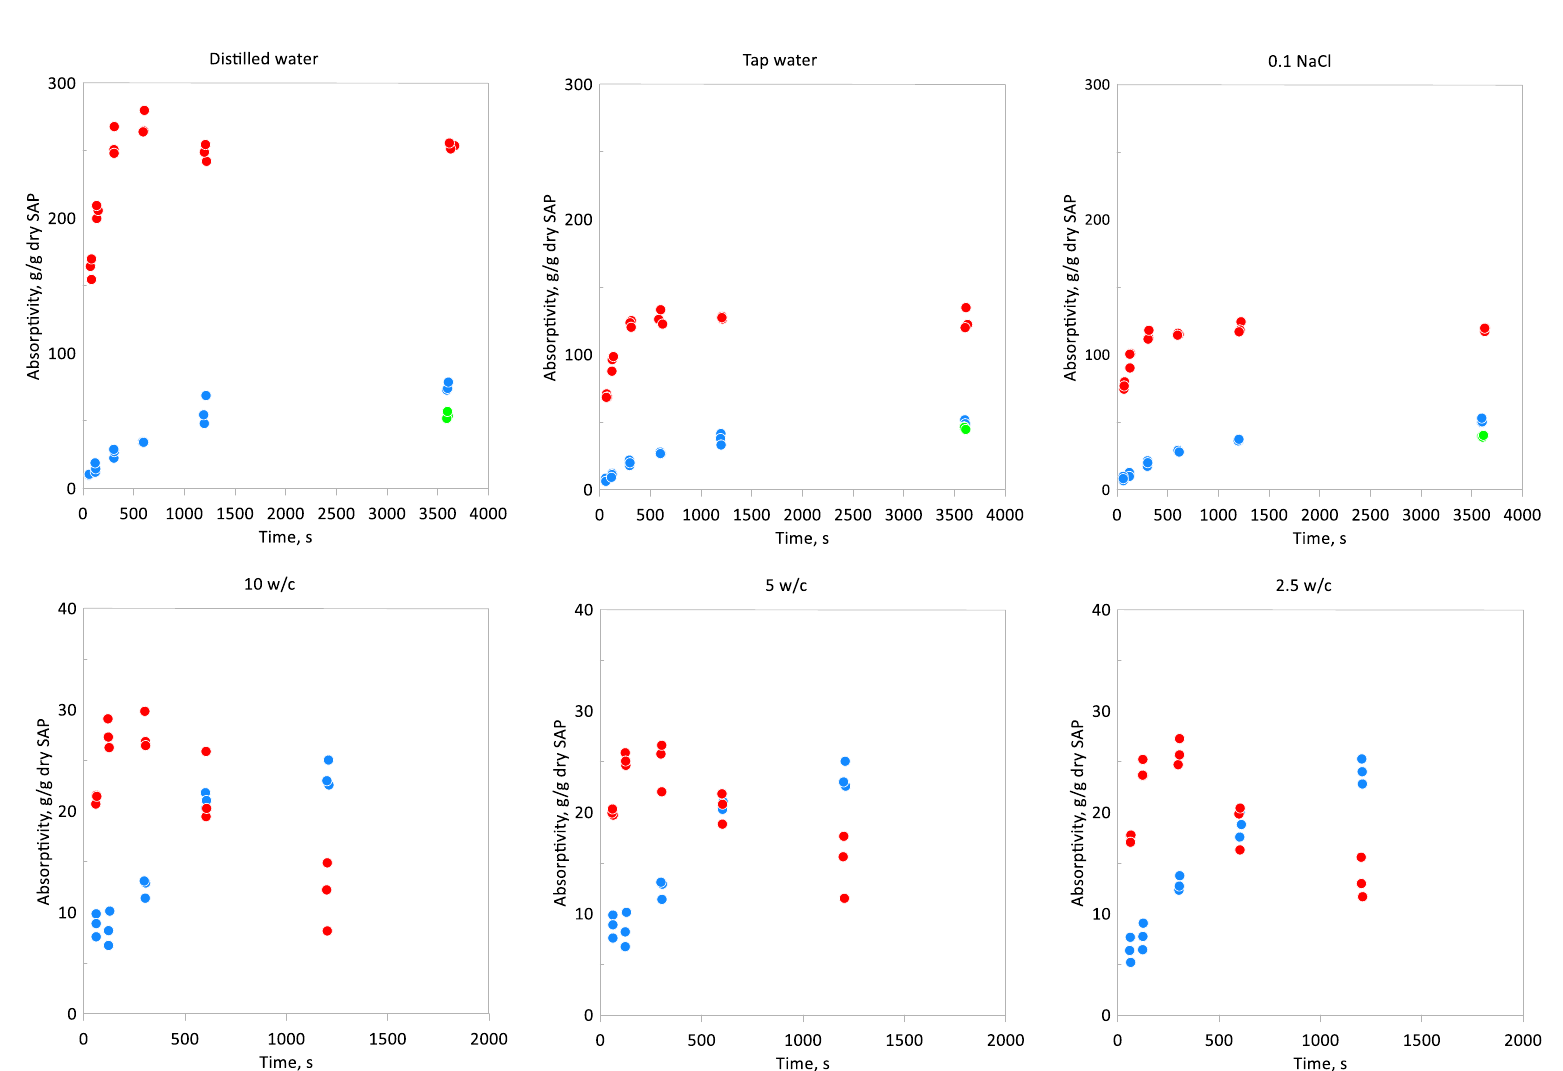
Figure 3. Results of sorption experiments as a time function: ● Cablock CT, ● Hydropam, and ● Creasorb SIS.